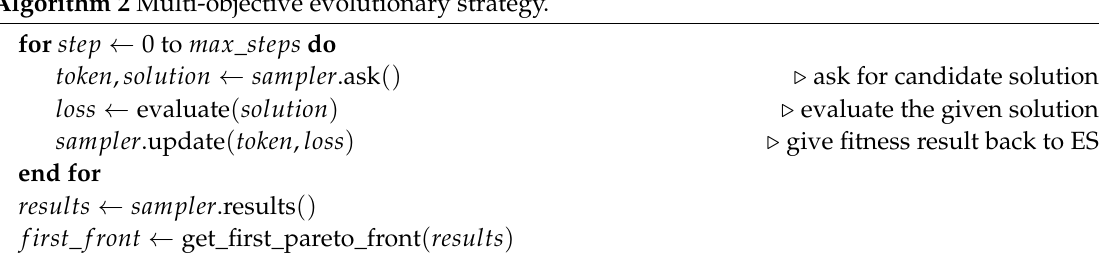
Algorithm 2 Multi-objective evolutionary